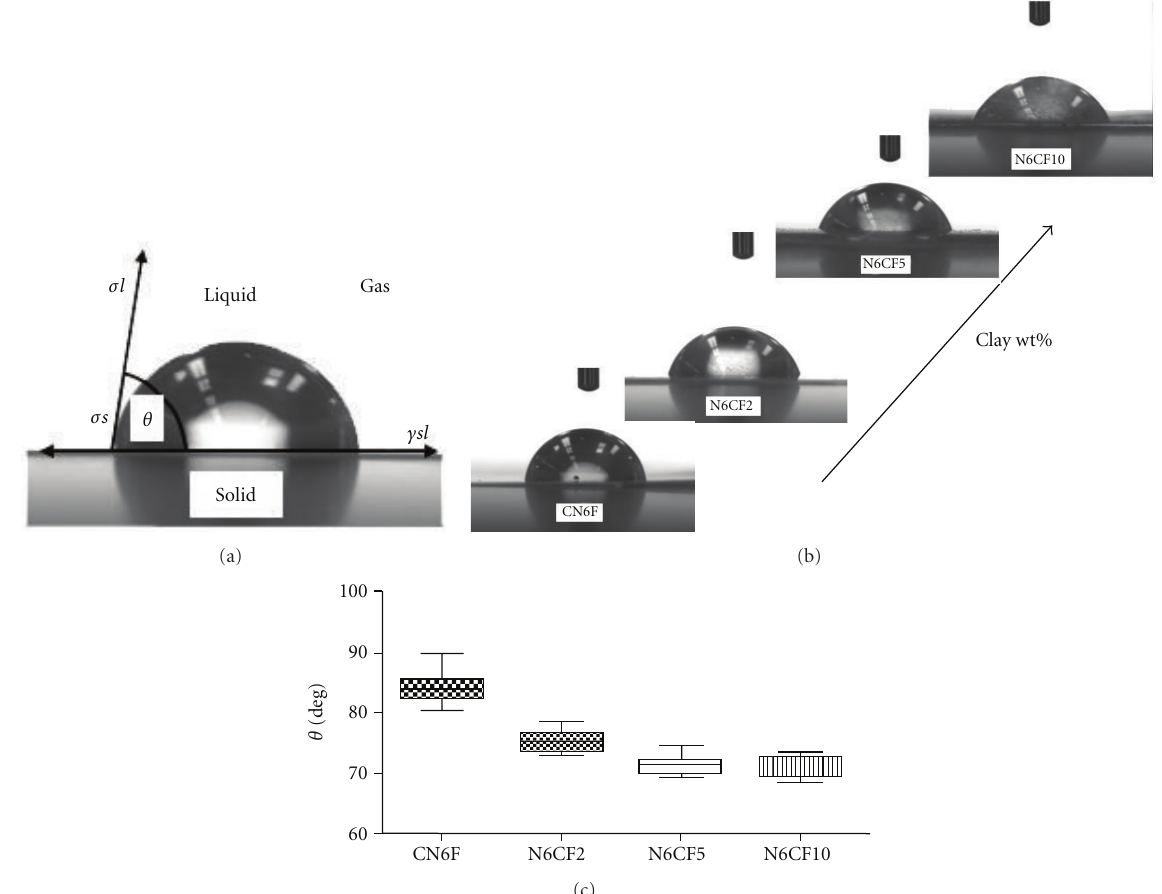
Figure 13: Results of contact angle analysis (a) contact angle formation on a solid surface according to YOUNG, (b) contact angle formation on di ff erent blown film samples, and (c) results of contact angle theta for sample with increasing wt%